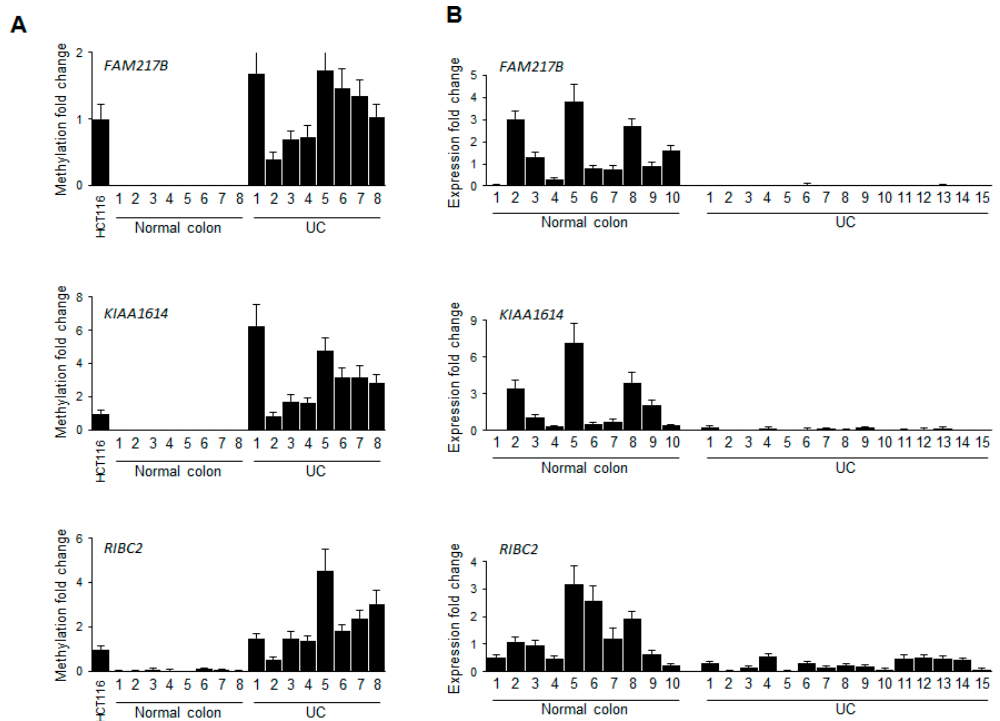
Figure 4. Correlation between promoter hypermethylation and transcriptional silencing in UC patient tissues and in controls. ( A ) Quantitative MSP and ( B ) RT-PCR analyses of FAM217B , KIAA1614 and RIBC2 genes in selective UC patient samples and controls. HCT116 cells were used as a positive control for methylation levels. All quantitative methylation levels were normalized by the Alu element. Human GAPDH was used for expression normalization. Statistical significance ( p < 0.001) for all three genes is shown between UC patient tissue samples and controls.